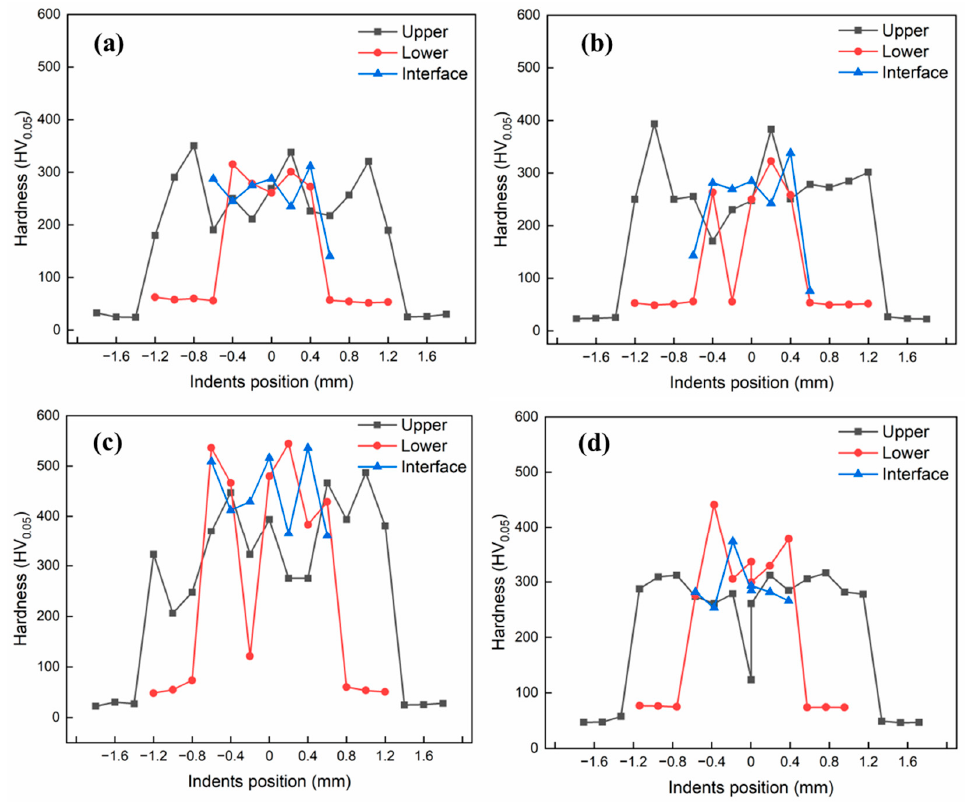
Figure 14. Hardness profile as a function of the distance from the weld center: ( a ) A4; ( b ) B4; ( c ) C2; ( d ) C4. Table 5. Characteristics of intermetallic compounds [20].